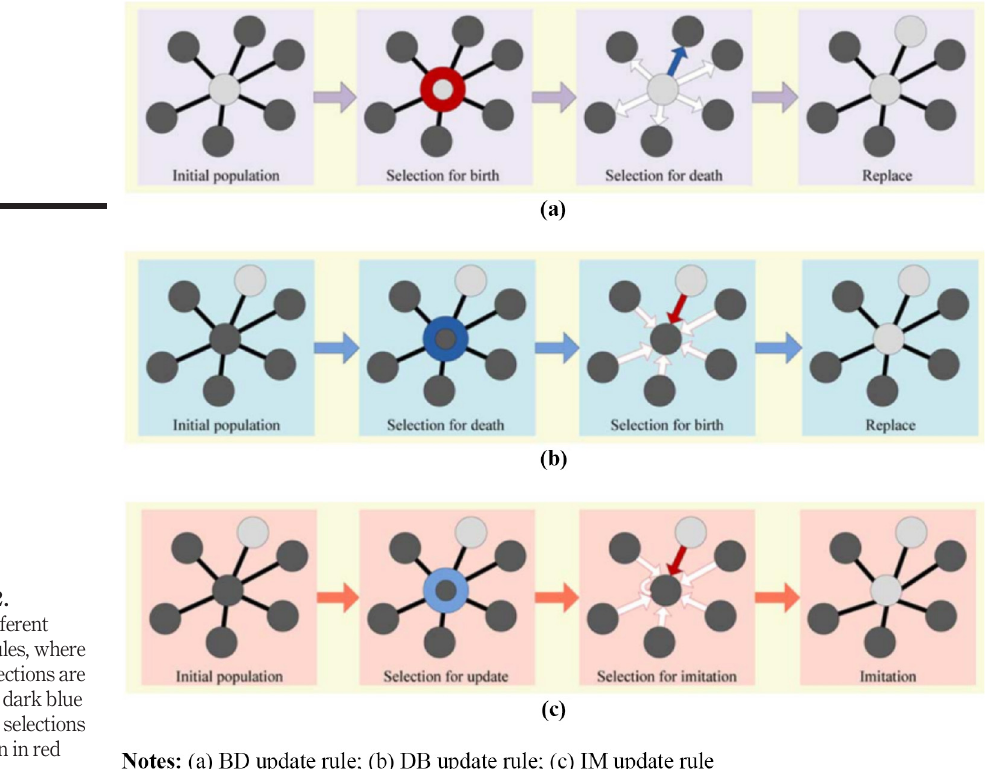
Figure 2. Three different update rules, where death selections are shown in dark blue and birth selections are shown in (3) IM updating rule: each player either adopts the strategy of one neighbor or remains his/her current strategy, with the probability being proportional to fi tness.